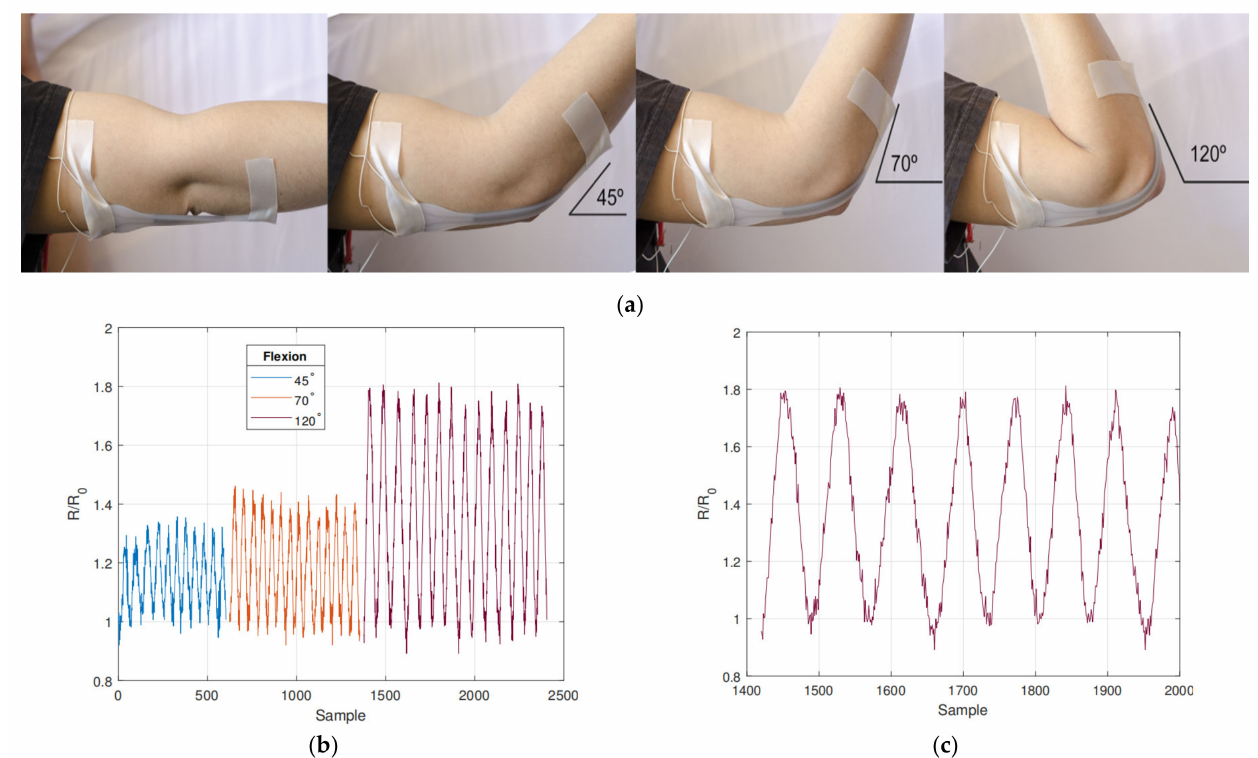
Figure 16. Resistive strain sensor attached to the elbow with three ranges of flexion. ( a ) Resistive strain sensor with elbow angle at 0, 45, 70, and 120 degrees. ( b ) Arm is moved from zero degrees to desired angle and back several times each, generating the waveform. ( c ) Data from repeated 120 ◦ flexion. Reprinted with permission from Ref. [26]. Copyright 2018